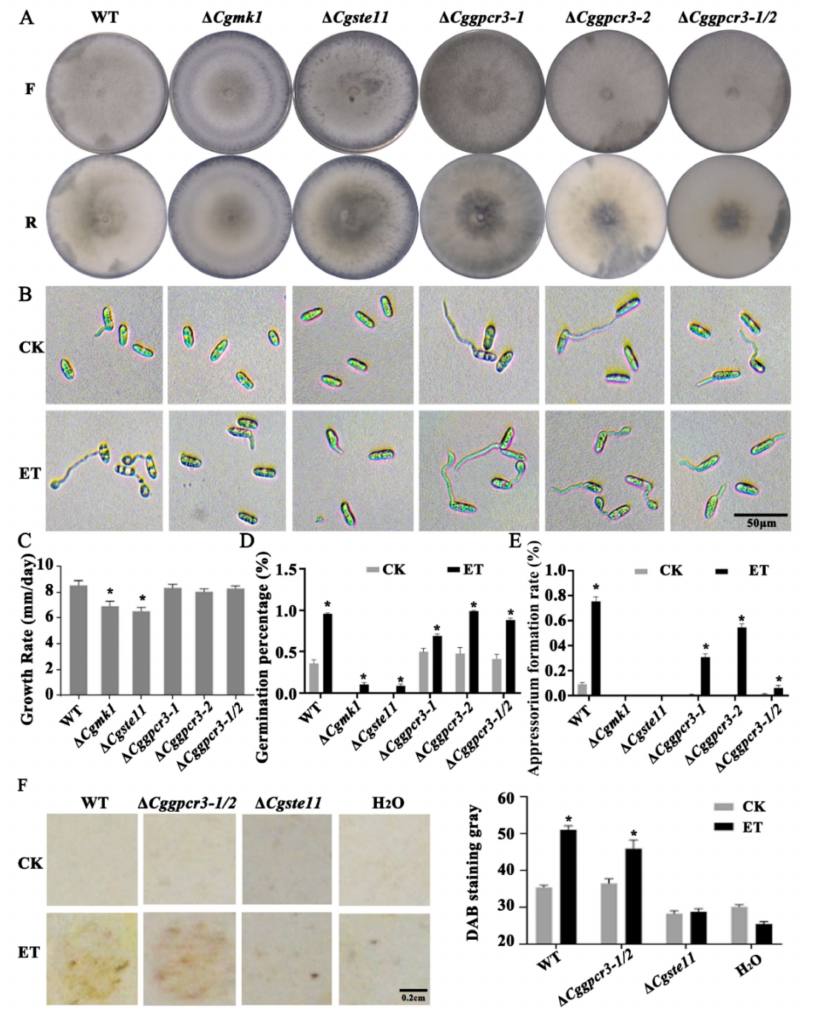
Figure 7. MAPK and GPCRs were involved in mediating ET signaling to promote appressorium development and pathogenicity. ( A , C ) The front (F) and reverse (R) sides of colony morphology and expansion rates of the strains grown on PDA for 5 days. ( B , D , E ) The effect of ET on spore germination and appressorium development at 4 h after incubation on glass slides. ( F ) The influence of ET on ROS accumulation of the plant leaves infected with WT, ∆ Cgste11 , and ∆ Cggpcr3-1/2 strains at 24 h after inoculation. For ( C – F ): p < 0.05